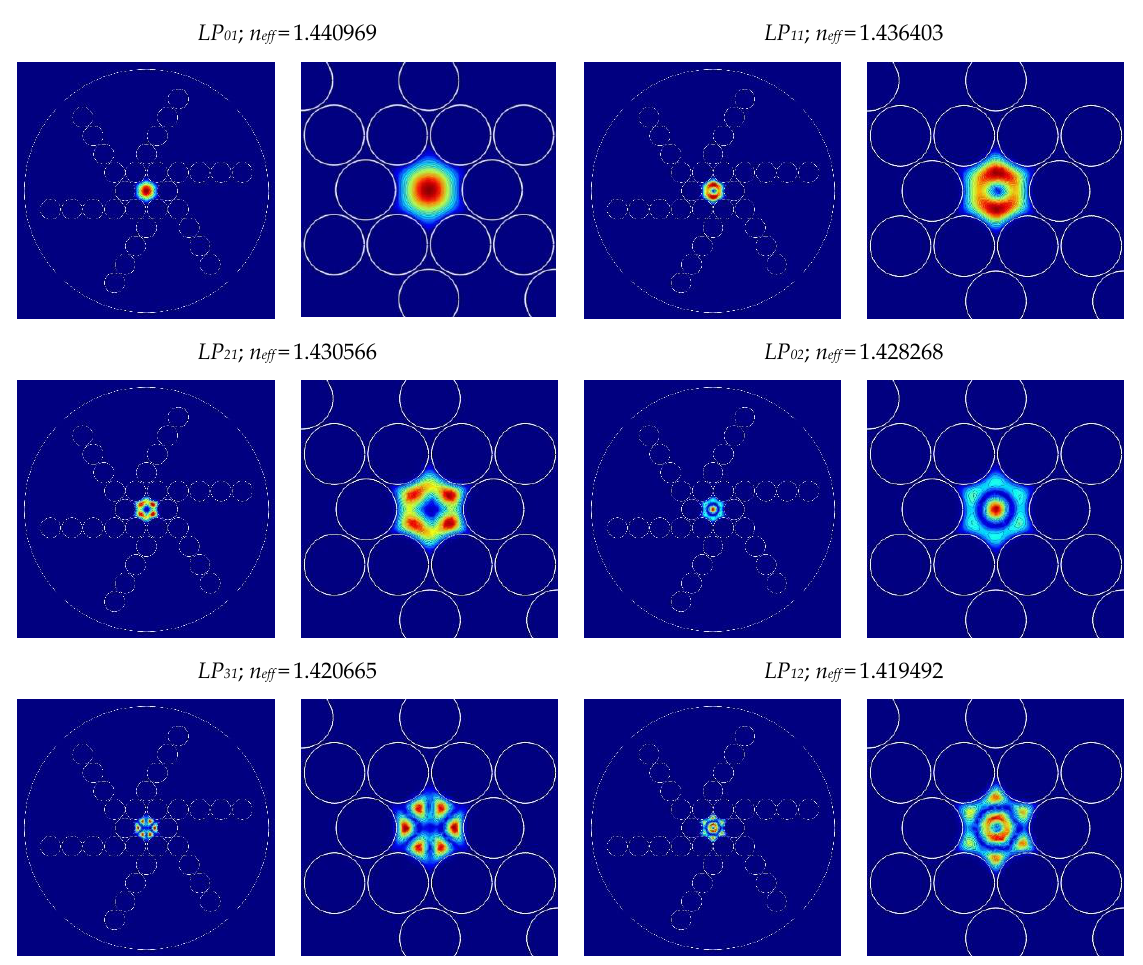
Figure 9. Computed radial distributions of guided mode fields.